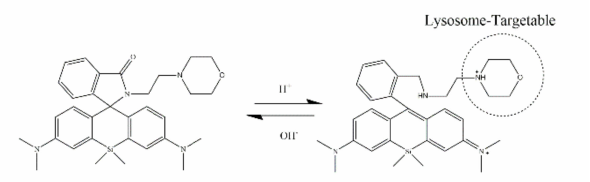
Figure 36. The response mechanism of Lyso-NIR-pH (Table 2, No. 1) to pH in lysosome